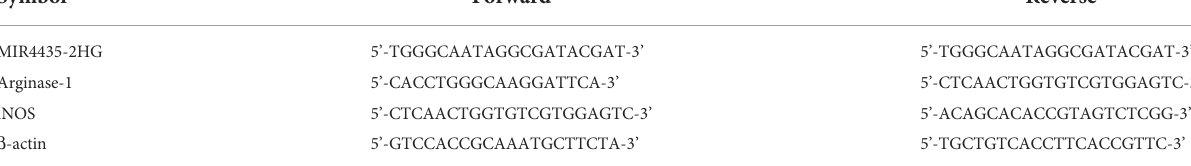
TABLE 1 Gene primer